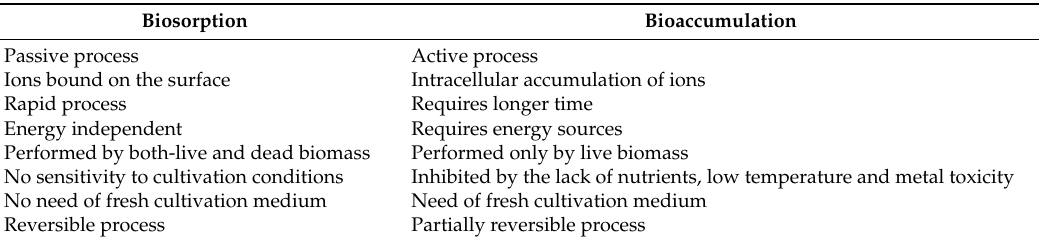
Table 1. The main differences between biosorption and bioaccumulation